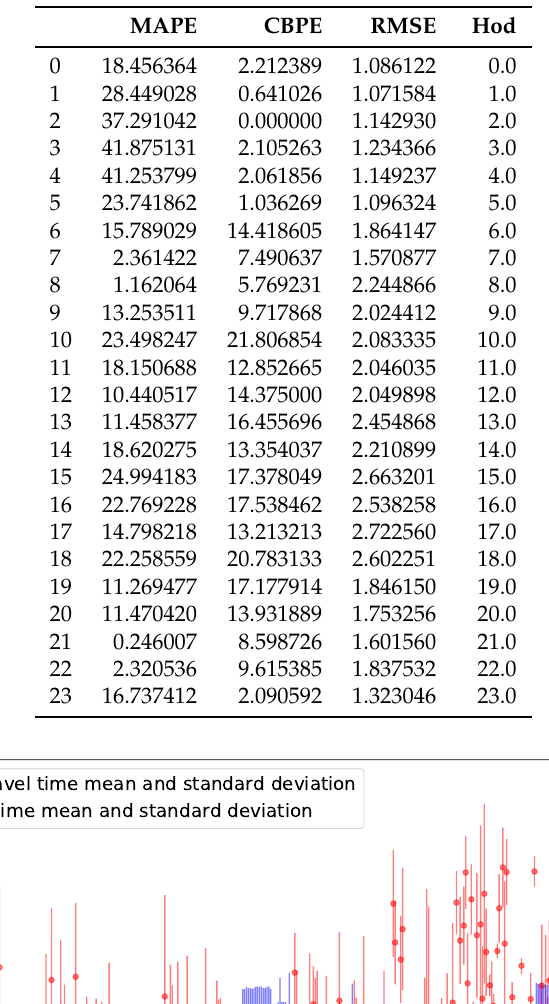
Table 3. CBPE, RMSE, and MAPE errors of estimated travel time compared to Uber movement data for different hours of a day.